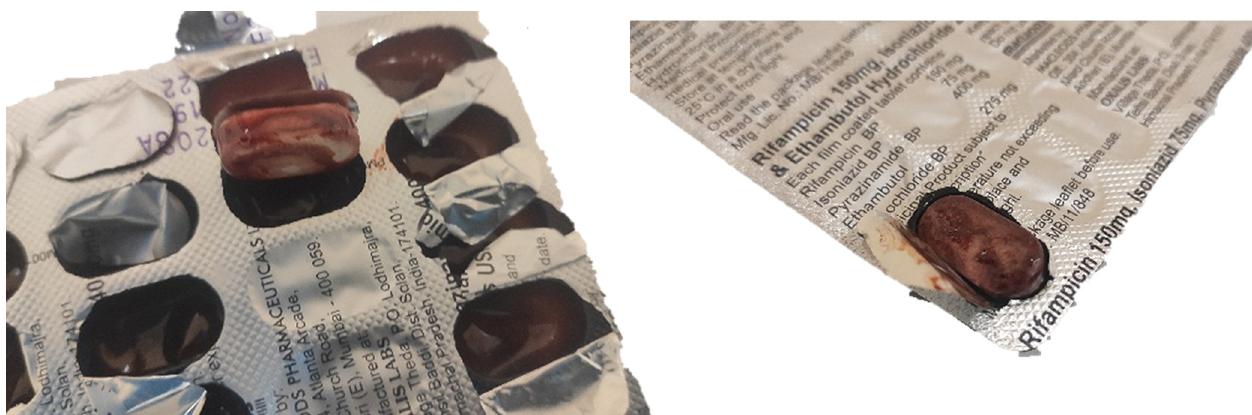
Fig 4. Appearance of two units wetted of RHZE-CDT at 3